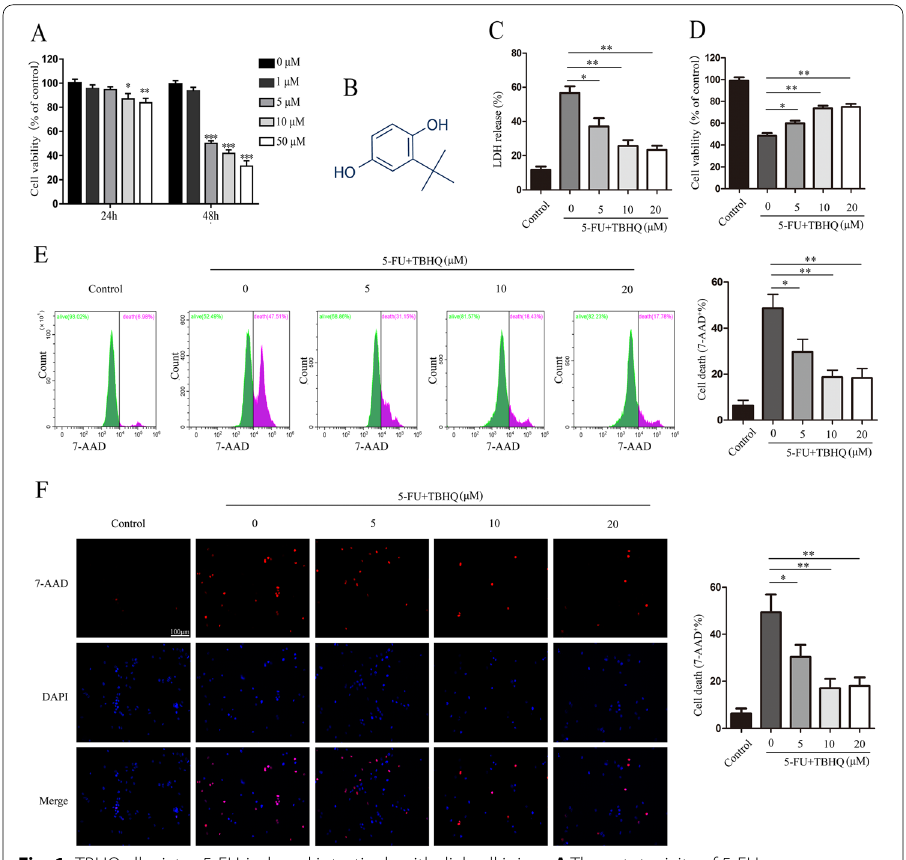
Fig. 1 TBHQ alleviates 5-FU-induced intestinal epithelial cell injury. A The cytotoxicity of 5-FU was determined using the CCK-8 assay in human intestinal epithelial cells. B The chemical structure of TBHQ. C 5-FU-induced lactate dehydrogenase (LDH) release was inhibited by treatment with TBHQ. D TBHQ increased cell viability following 5-FU treatment in a dose-dependent manner. E , F 7-AAD-positive cells were stained and counted using flow cytometry and fluorescent microscopy (scale bars: 100 μm). *p < 0.05, **p <